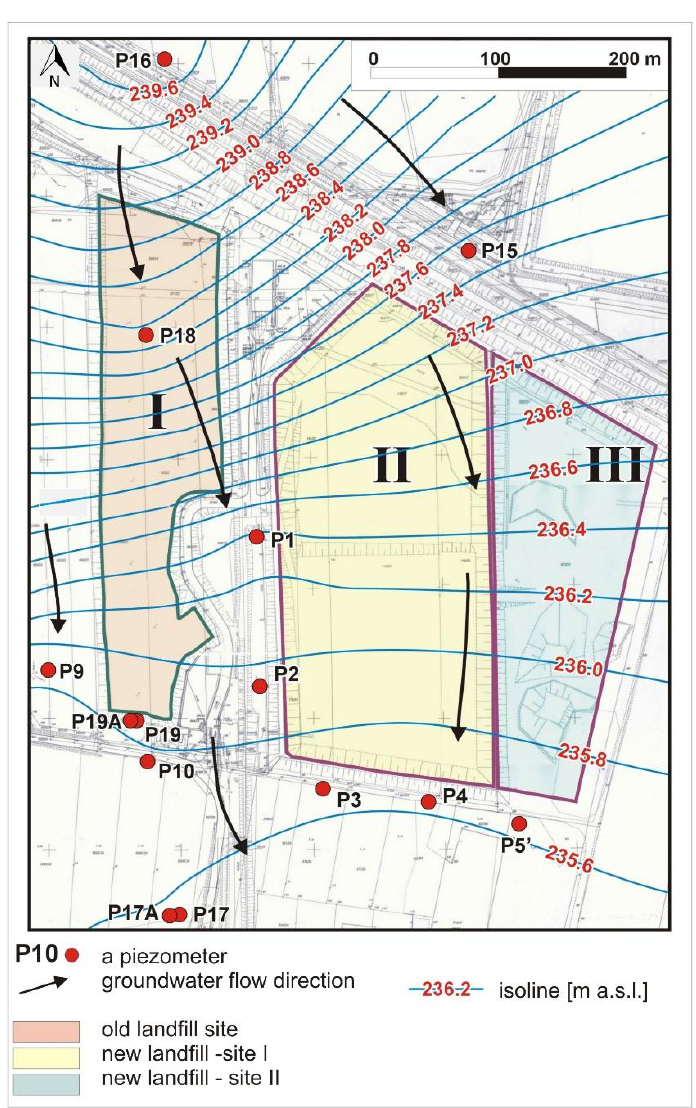
Figure 3. Contour map of the study area (based on [44])